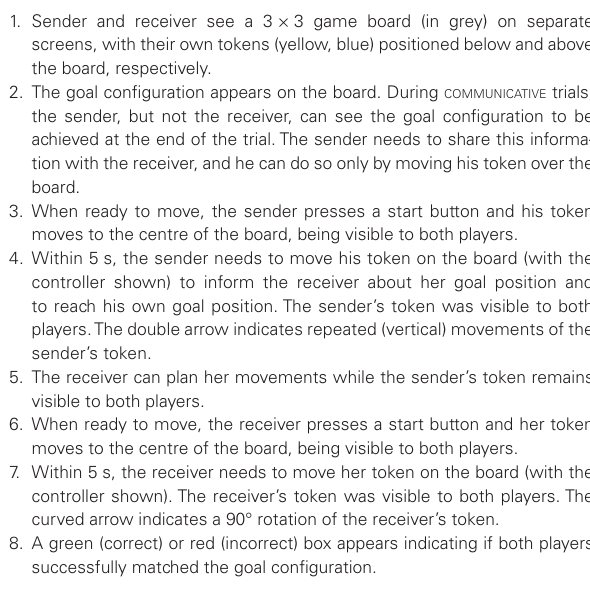
FIGURE 1 | Sequence of events in a COMMUNICATIVE trial of the tacit communication game (TCG). 1. Sender and receiver see a 3 × 3 game board (in grey) on separate screens, with their own tokens (yellow, blue) positioned below and above the board, respectively. 2. The goal confi guration appears on the board. During COMMUNICATIVE trials, the sender, but not the receiver, can see the goal confi guration to be achieved at the end of the trial. The sender needs to share this informa- tion with the receiver, and he can do so only by moving his token over the board. 3. When ready to move, the sender presses a start button and his token moves to the centre of the board, being visible to both players. 4. Within 5 s, the sender needs to move his token on the board (with the controller shown) to inform the receiver about her goal position and to reach his own goal position. The sender’s token was visible to both players. The double arrow indicates repeated (vertical) movements of the sender’s token. 5. The receiver can plan her movements while the sender’s token remains visible to both players. 6. When ready to move, the receiver presses a start button and her token moves to the centre of the board, being visible to both players. 7. Within 5 s, the receiver needs to move her token on the board (with the controller shown). The receiver’s token was visible to both players. The curved arrow indicates a 90° rotation of the receiver’s token. 8. A green (correct) or red (incorrect) box appears indicating if both players successfully matched the goal confi